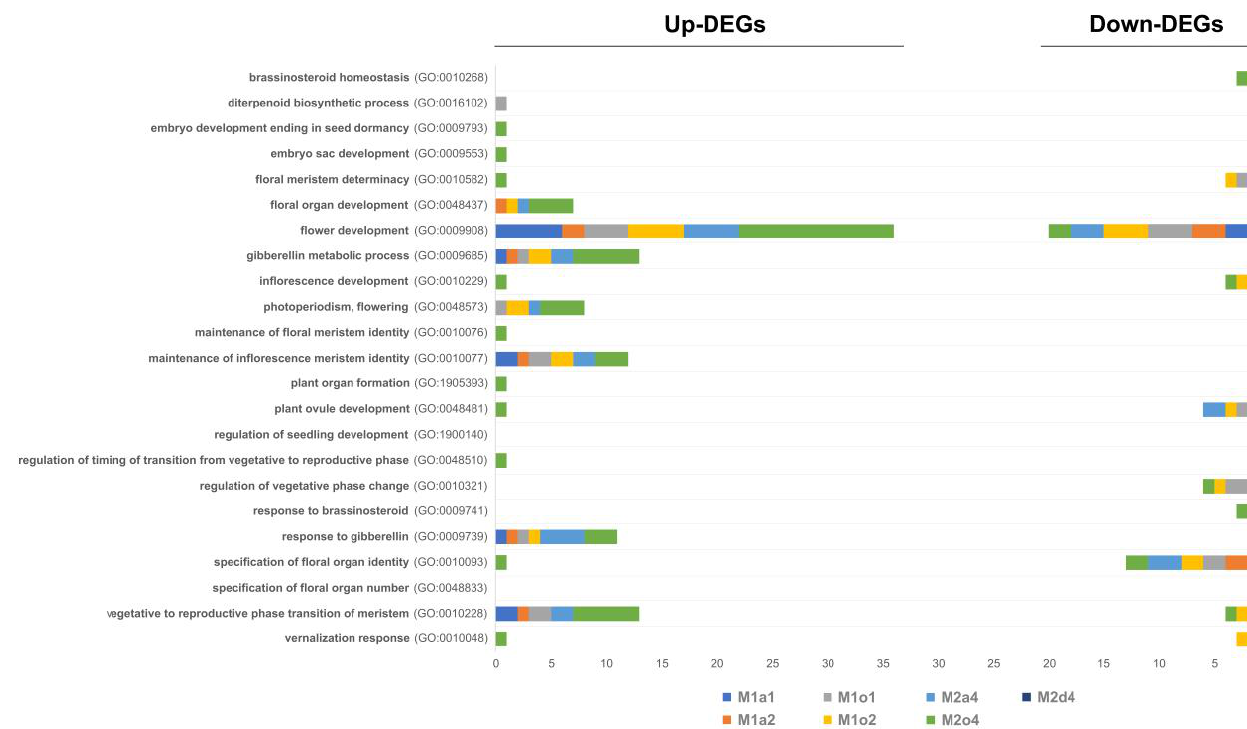
Figure 5. Regulation of up- and down-regulated differentially expressed genes (DEGs) in ovules in stages S1 (1), S2 (2), and S3/S4 (4) from apomictic L. multiflorum (M), sexual L auriculifolium (a) and L. ovalifolium (o), and facultative apomictic L. dodartii (d), annotated with female-related Gene Ontology (GO) terms. DEGs represent the number of significant genes found to be differently expressed in each comparison.